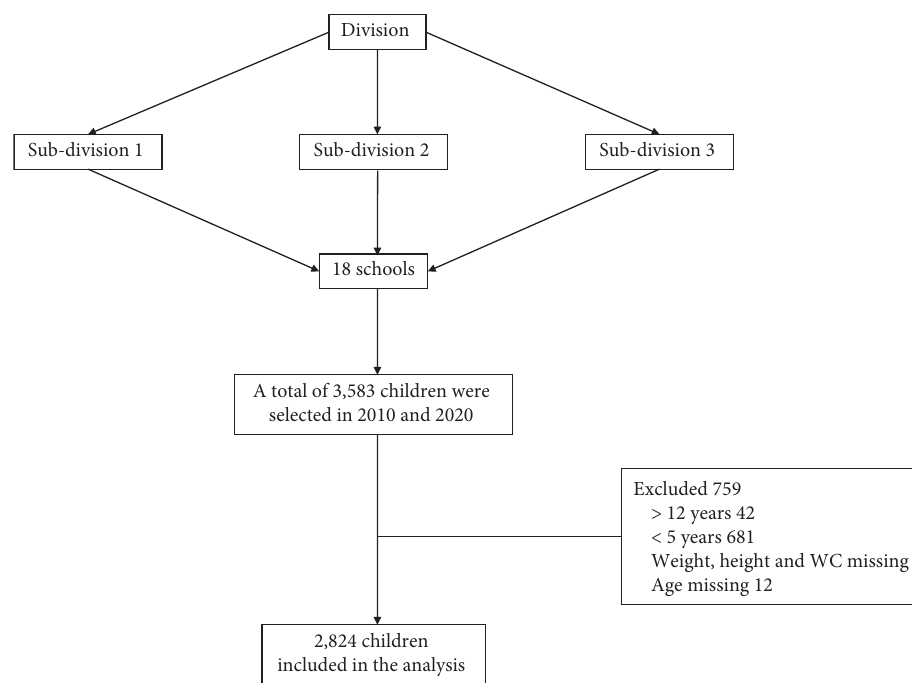
Figure 1: Flowchart of the sampling procedure/cleaning of data. Table 1: Descriptive characteristics of the study